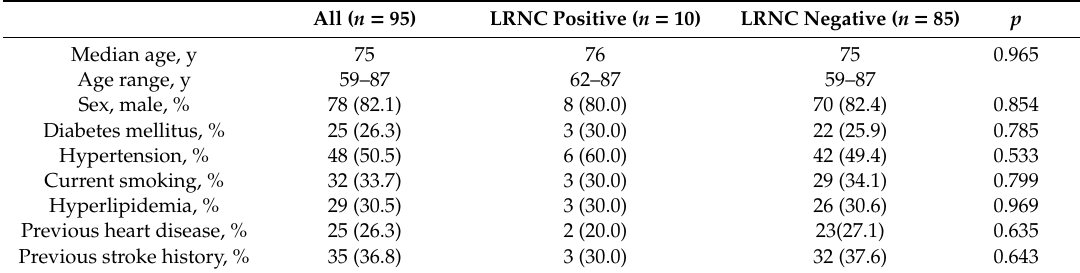
Table 1. Demographic data and clinical characteristics of the patients.